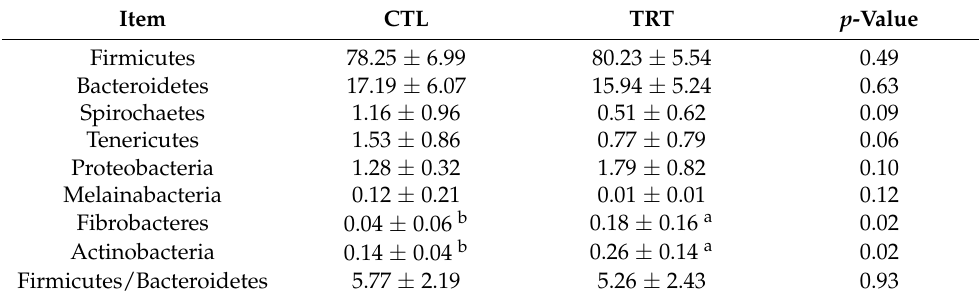
Data are expressed as mean ± SD. n = 10. CTL, sow fed the basal diet; TRT, sow fed basal diet with silymarin 40 g/d from late gestation to lactation. a,b Means not sharing identical superscripts in the same row are significantly different ( p < 0.05).